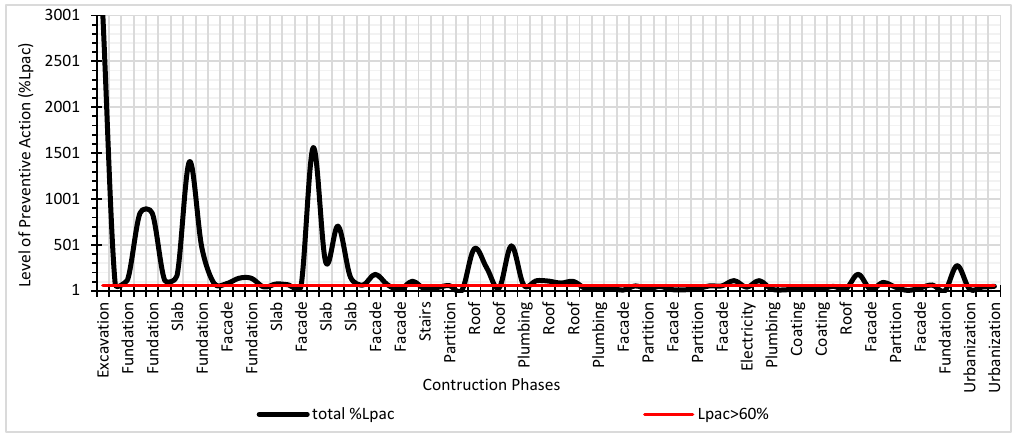
Figure 16. Global results of the Level of Preventive Action.